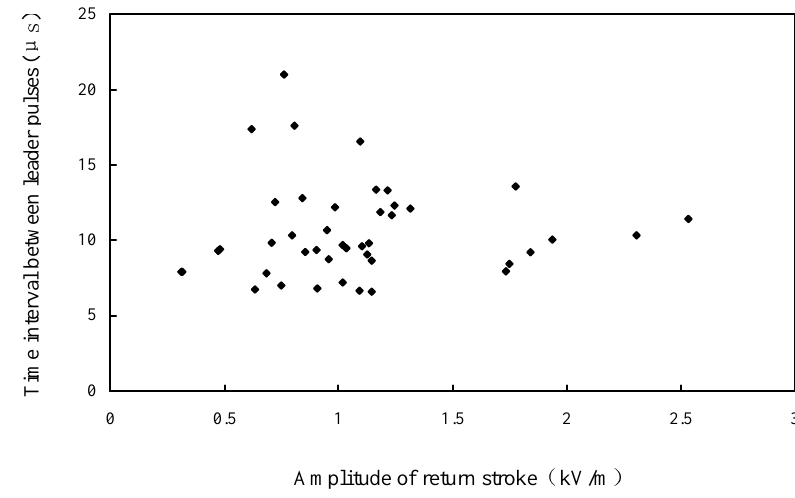
Fig. 5. Scatter plot of the time interval between leader step pulses versus amplitude of the following return stroke pulse.